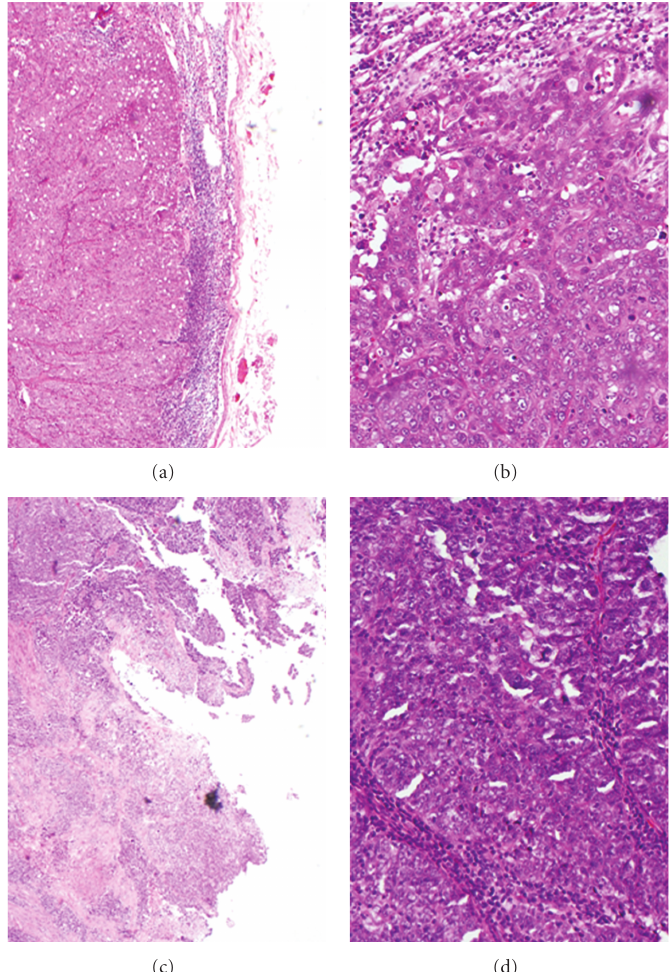
Figure 1: Haematoxylin and eosin-stained sections of the tumour, as the presenting metastasis seen within the lymph node ((a) and (b), 10x and 20x, resp.) and the subsequent resection of the fallopian tube ((c) and (d), 10x and 20x,